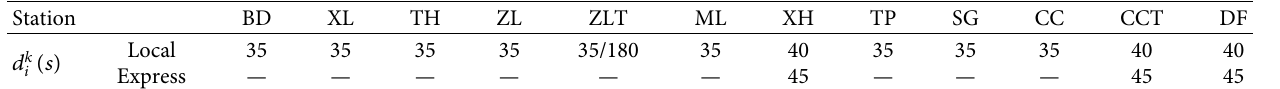
Table 5: Passenger flow within t